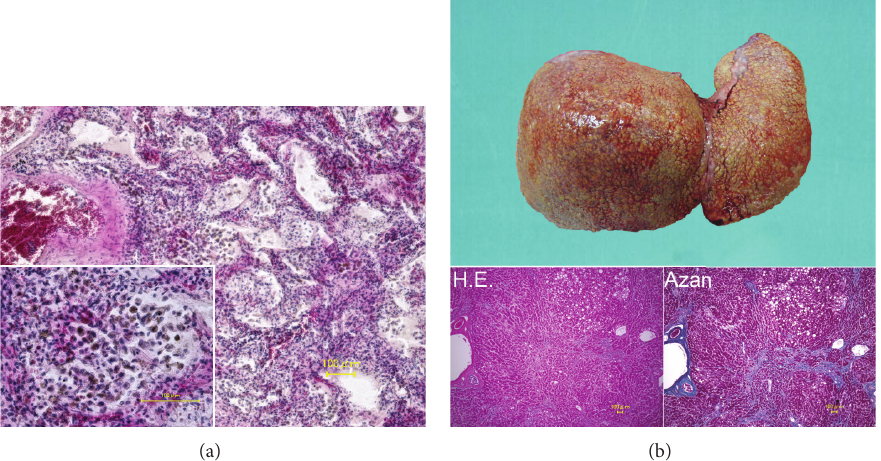
Figure 1: (a) Lung. Microscopic alveolar examination showing diffuse inflammatory macrophage and lymphocyte cell infiltration, suggesting pulmonary pneumonia. (b) Liver. Macroscopic examination showed liver cirrhosis. Microscopic examination showed pseudolobule in the liver (hematoxylin eosin staining and Azan